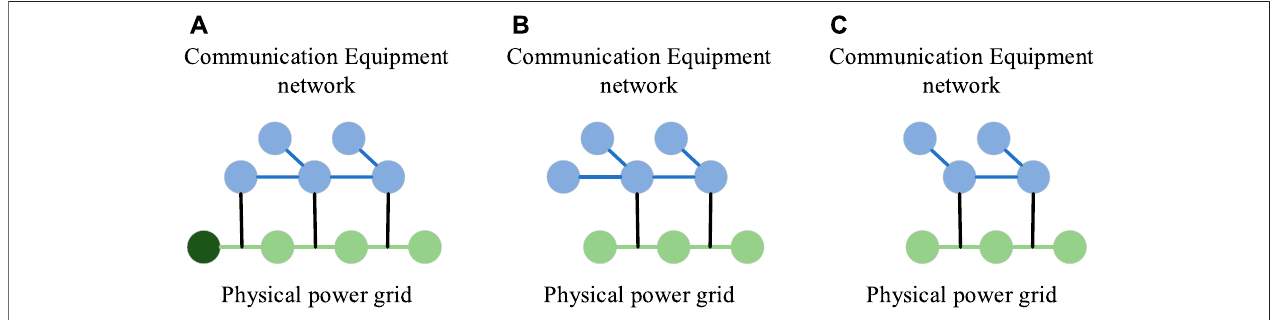
FIGURE 1 | Cascading process of cyber node failure (A – C) . (A) The fi rst step of the cascading failure. (B) The second step of the cascading failure (C) is the third step of the cascading failure.